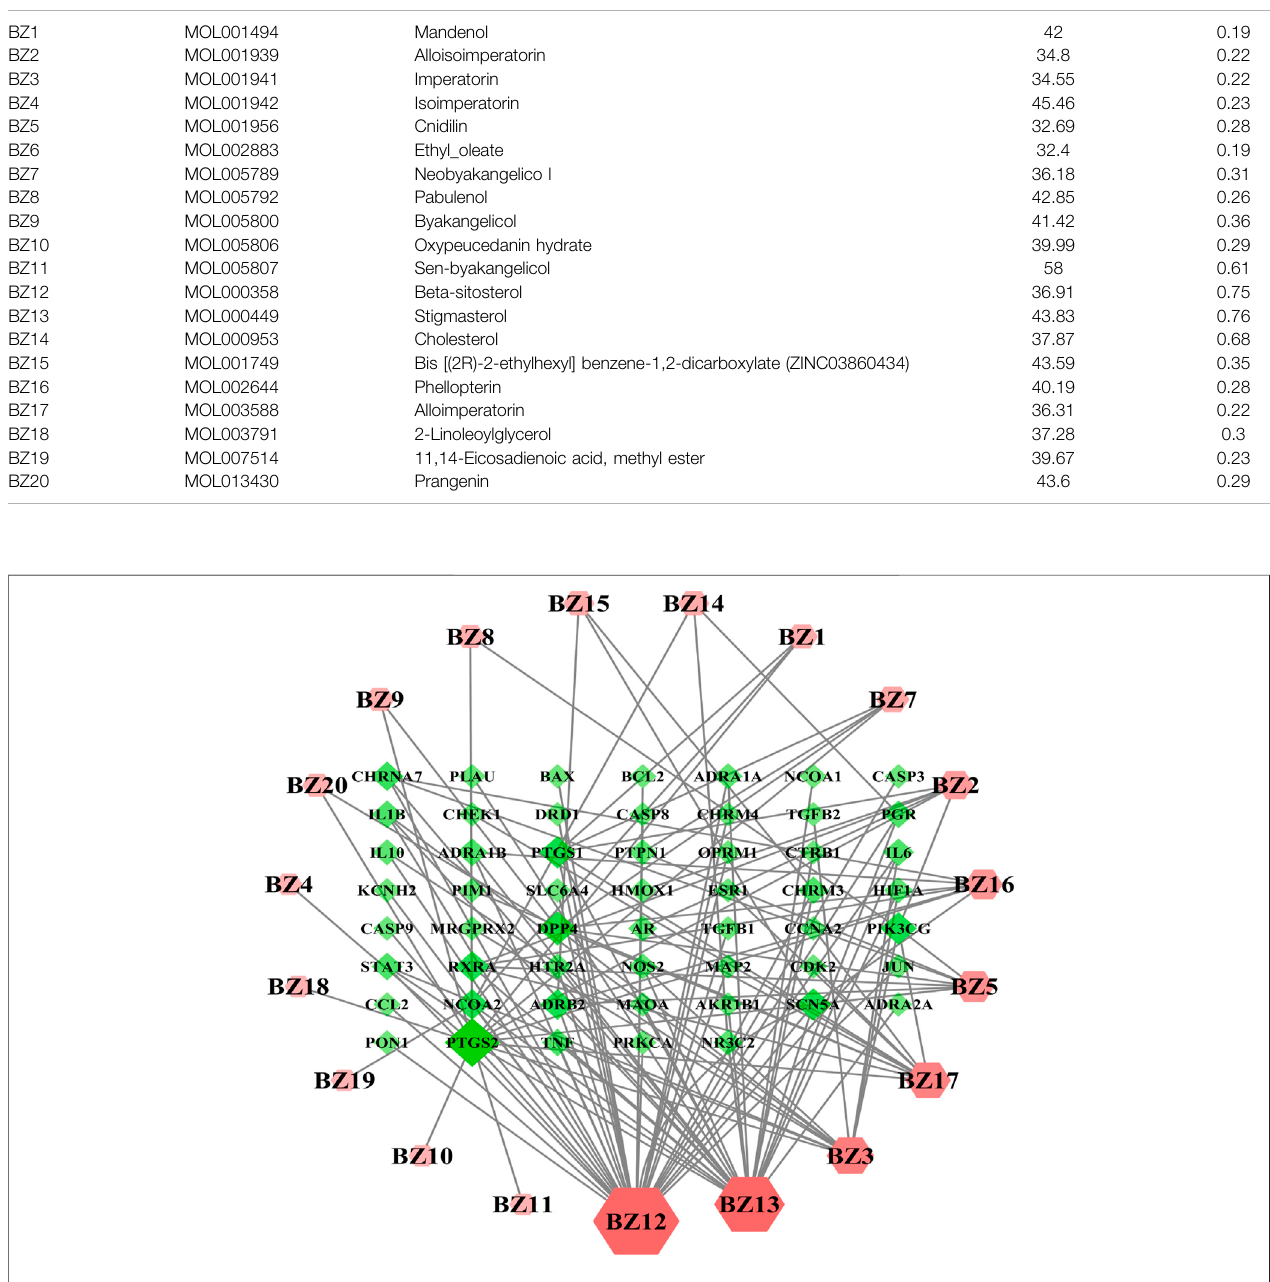
FIGURE 1 | The Compounds-Genes (C – G)